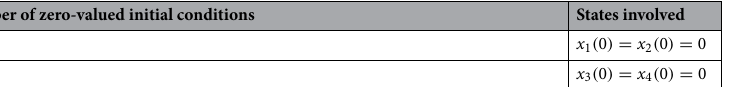
Table 2. Zero-valued initial condition combinations that result in the loss of structural identifiability of the Pharmacokinetics model ( M 5 ).